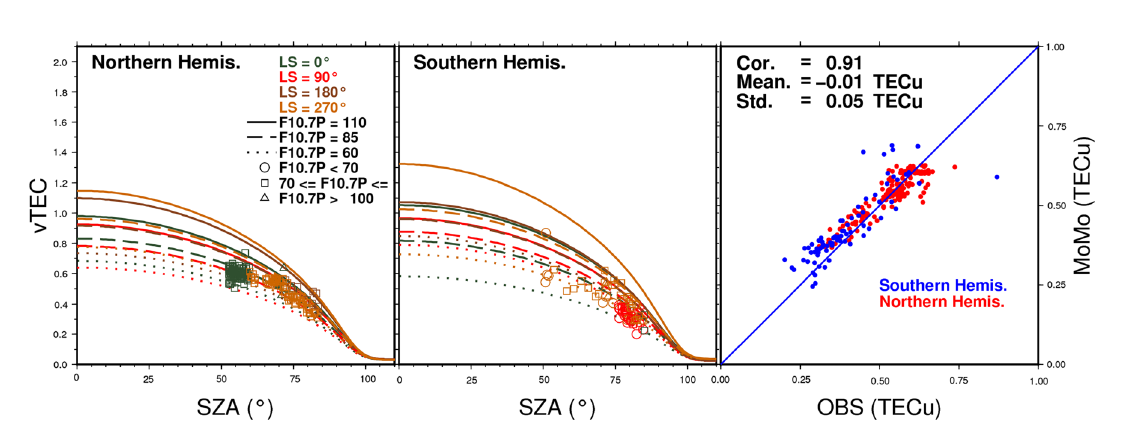
vTEC at different locations (top Northern hemisphere, bottom Southern Hemisphere corresponding to 20 (cid:3) N and 20 (cid:3) S respec-